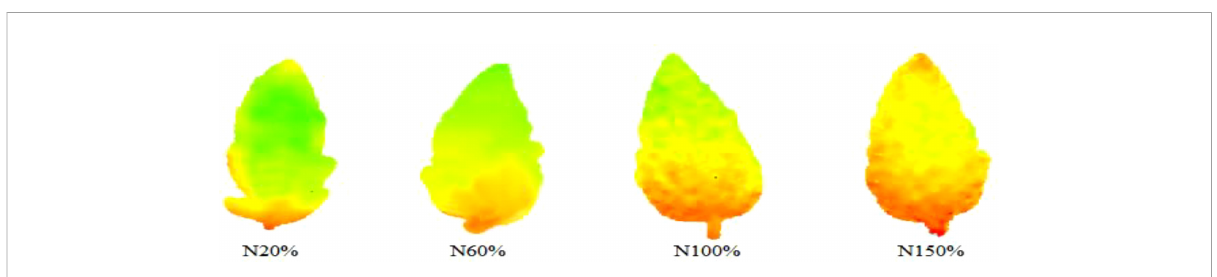
FIGURE 11 THz images of leaves with different nitrogen levels in the characteristic frequency bands screened by the SCARS